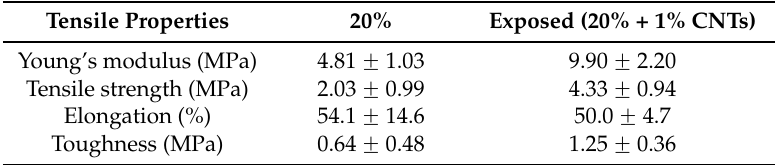
Figure 8. Mechanical properties of nylon 6 non-woven fiber mats electrospun from 20 wt % solutions and 20 wt % nylon 6 solutions with 1 wt % CNTs before/after formic acid vapor exposure for 30 min at room temperature. Table 4. Tensile properties of nylon 6 non-woven fiber mats electrospun from 20 wt % solutions, and from 20 wt % nylon 6 solution with 1 wt % CNTs after formic acid vapor exposure for 30 min at room